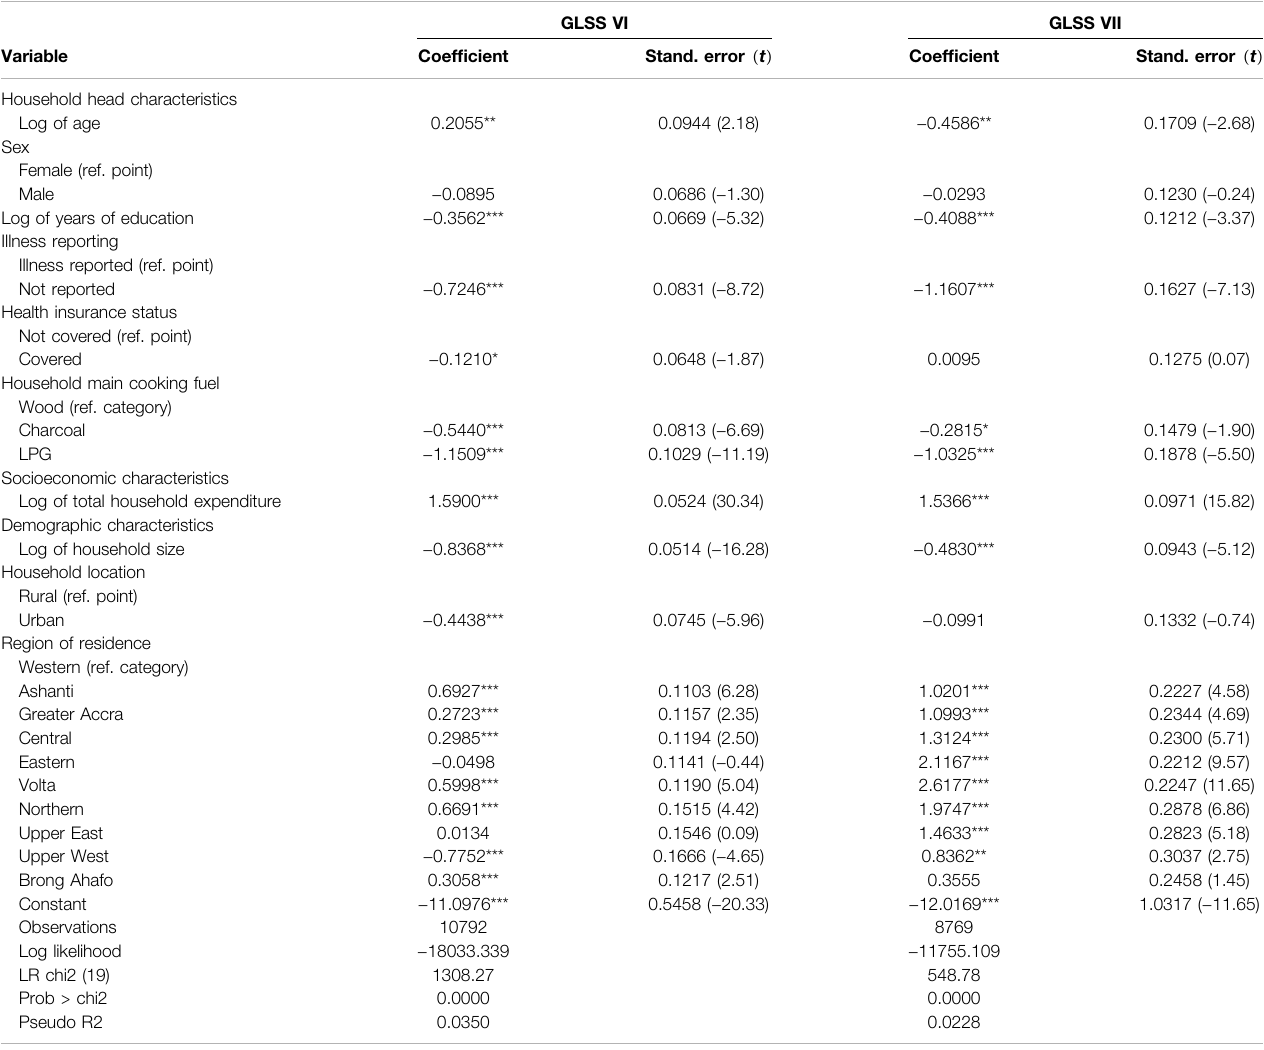
TABLE 2 | Tobit estimation